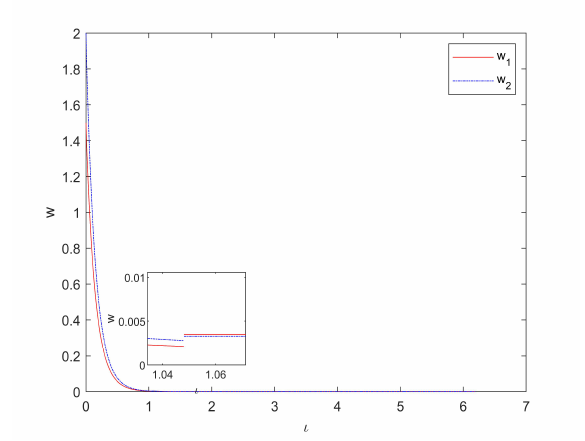
Figure 1. The positive almost periodic solution of model (8).